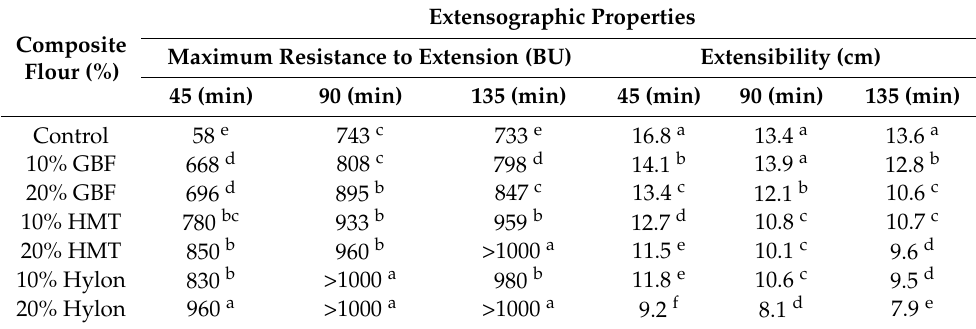
Table 2. Extensographic properties of composite flour with different proportions of resistant starch sources at different resting times.